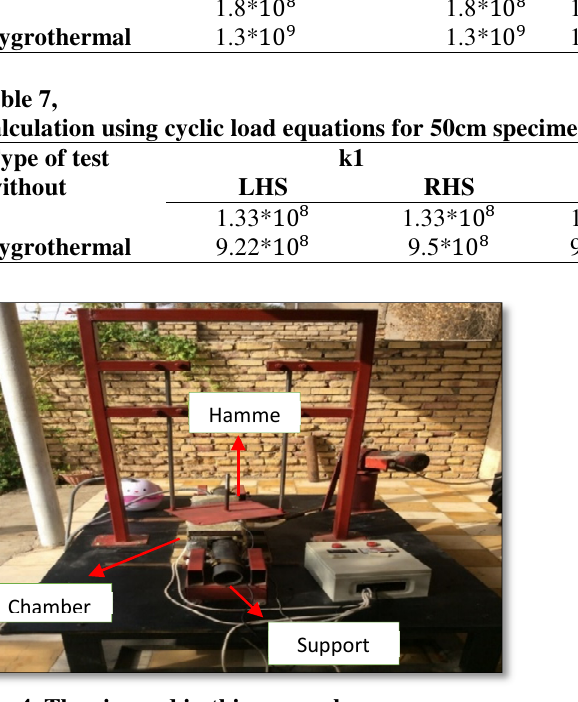
Fig. 4. The rig used in this research.